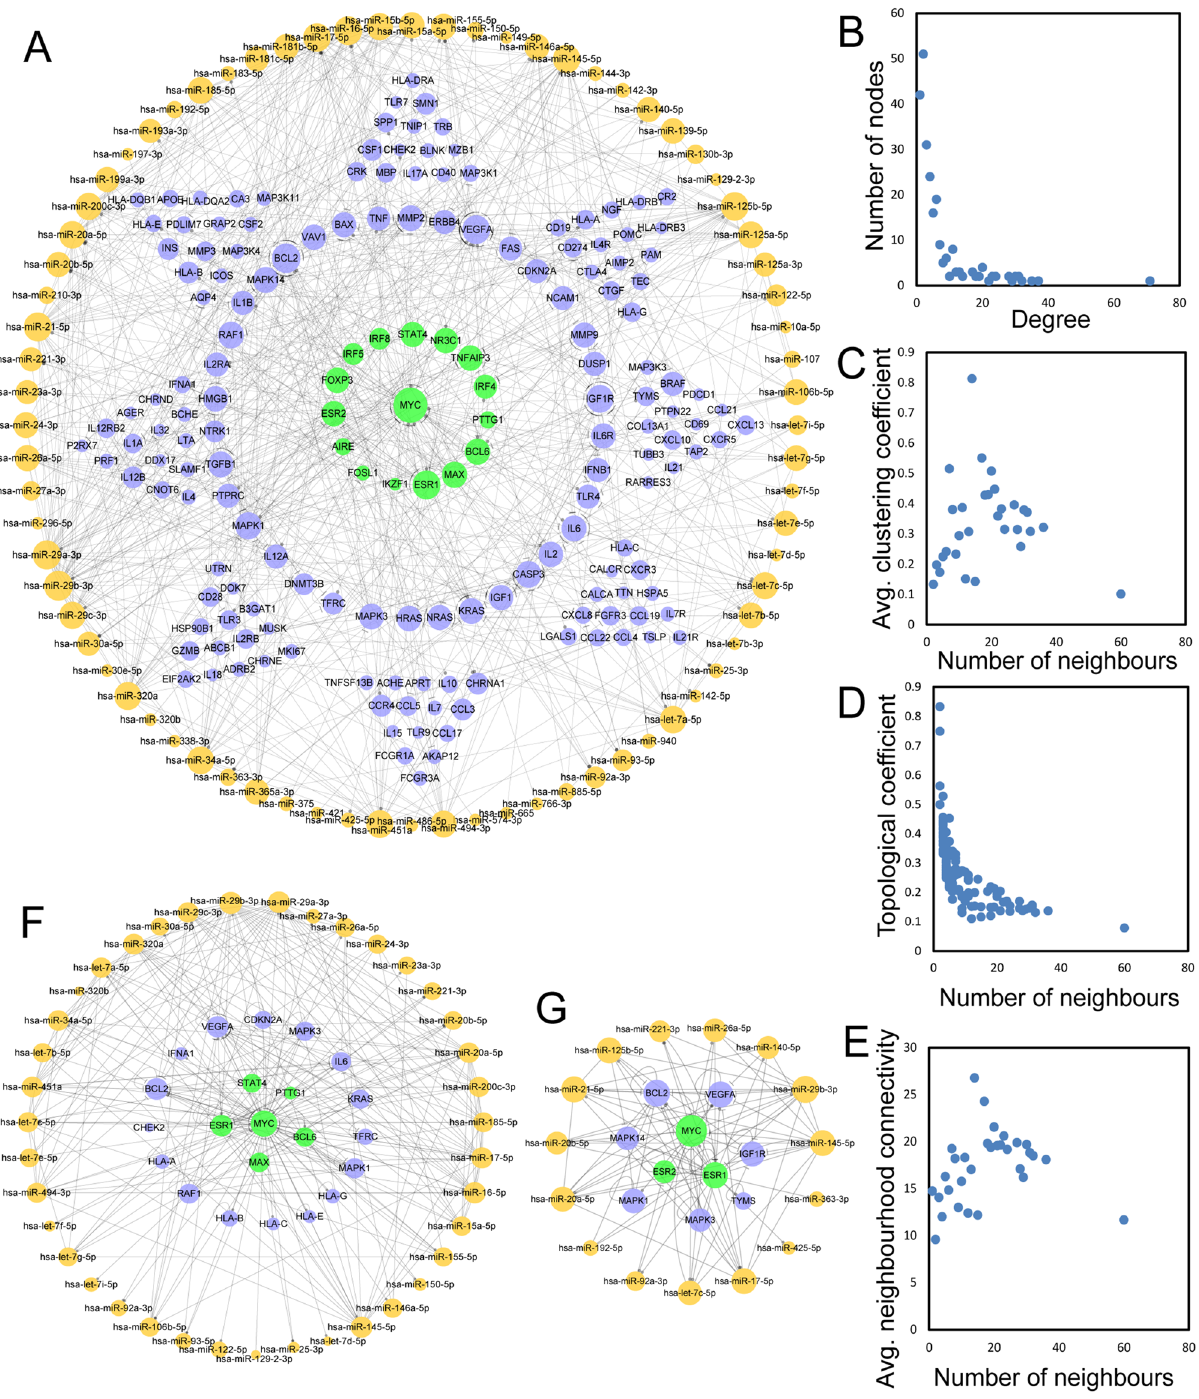
Figure 1. The basic characteristics of TMGN with all six types of regulatory pairs (miRNA–gene, miRNA–TF, TF–miRNA, TF–gene, gene–gene and miRNA–miRNA). ( A ) A global of the network of TMGN. TFs, miRNAs and genes are colored green, orange and blue, respectively. ( B – E ) The basic features of the network include degrees, clustering coefficients, topological coefficients and neighborhood connectivity of the network. ( F ) A sub-network with MYC as the central node. ( G ) A sub-network with ESR1 as the central node. TMGN: TF– miRNA–gene network; TF: transcription